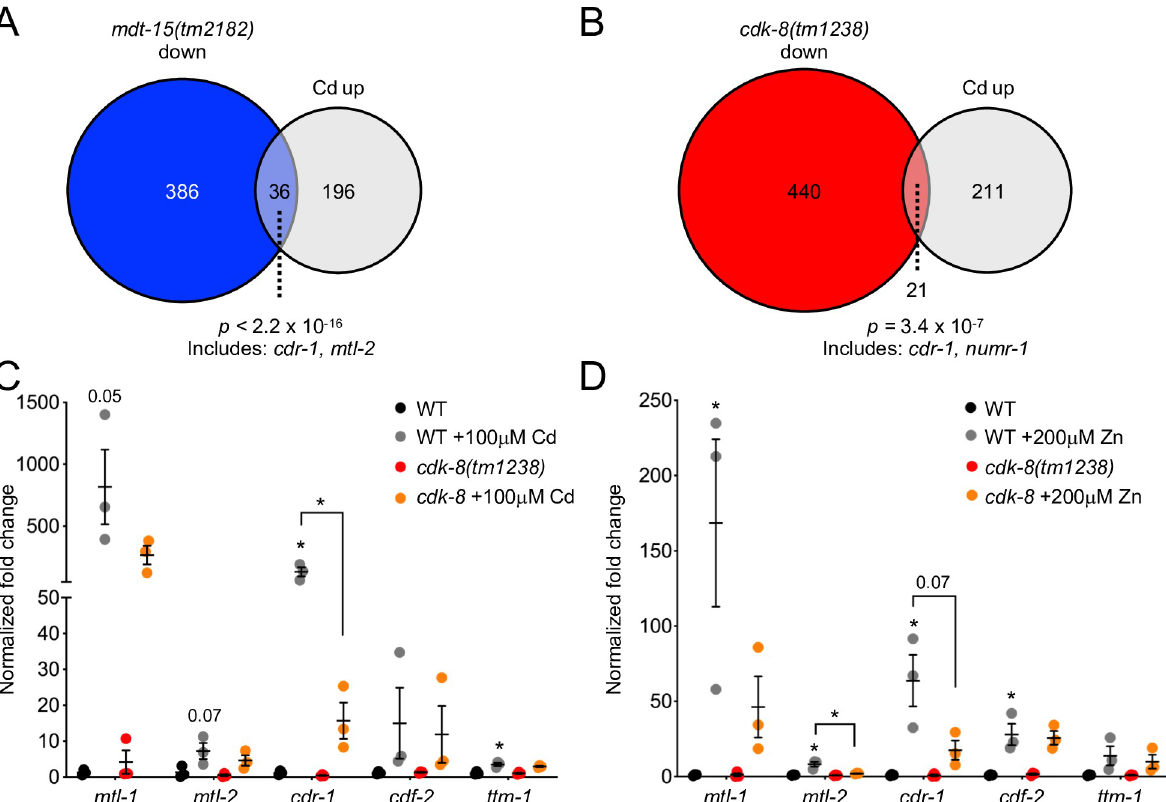
Fig 1. Mediator subunits mdt-15 and cdk-8 are required for cadmium and zinc stress responses. [A] The Venn diagram depicts the overlap between genes downregulated in the mdt-15(tm2182) mutant and genes induced by cadmium (identified in [43]). Statistical significance was assessed by Fisher’s exact test. Shared genes include cdr-1 and mtl-2 , which are known to function in cadmium biology [40,41].See S1 Table for details. [B] The Venn diagram depicts the overlap between genes downregulated in the cdk-8(tm1238) mutant and genes induced by cadmium. Statistical significance was assessed by Fisher’s exact test. Shared genes include cdr-1 and numr-1 , which are known to function in cadmium biology [40,42,44]. See S1 Table for details. [C-D] qRT-PCR analysis of zinc and cadmium-responsive genes in wild-type (WT) and cdk-8(tm1238) mutant worms grown on 100 μ M cadmium for 4 hours [C] or on 200 μ M zinc for 16 hours [D]. Graphs show fold induction, normalized to the average of unsupplemented WT mRNA levels. Error bars: SEM (n = 3 independent repeats). Statistical analysis: � p < 0.05, unpaired t-test comparing WT supplemented worms to WT supplemented worms, except for comparisons indicated by lines (note, only significant or near-significant (p < 0.075) values are